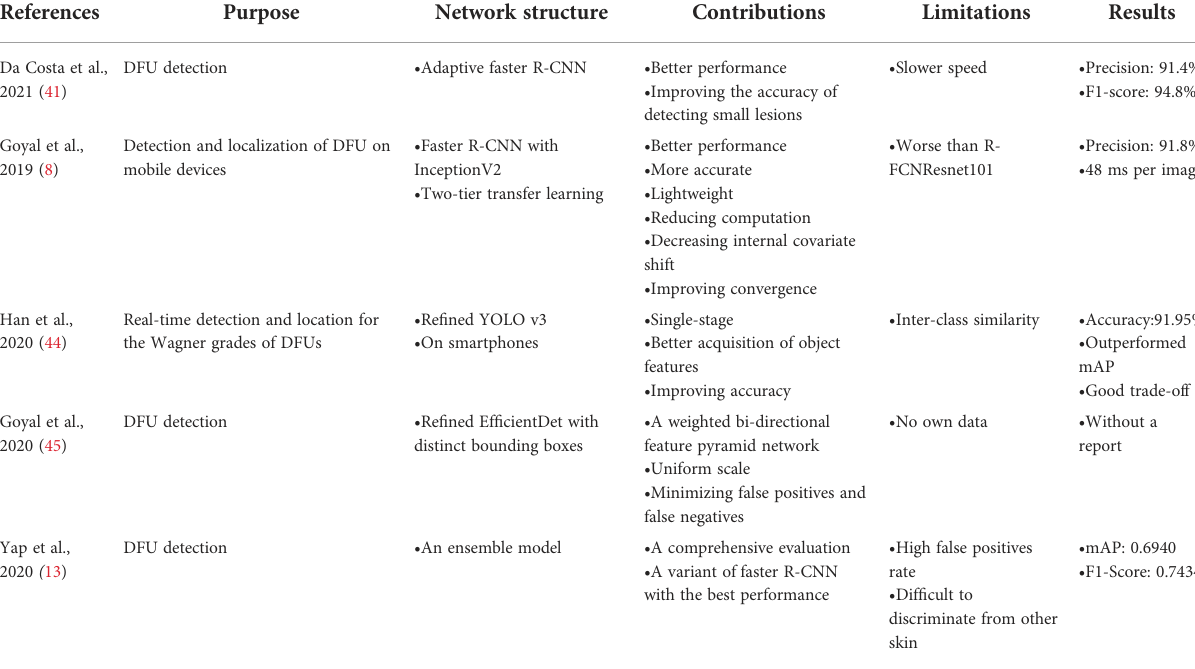
TABLE 2 Summary of deep learning in object detection for images of